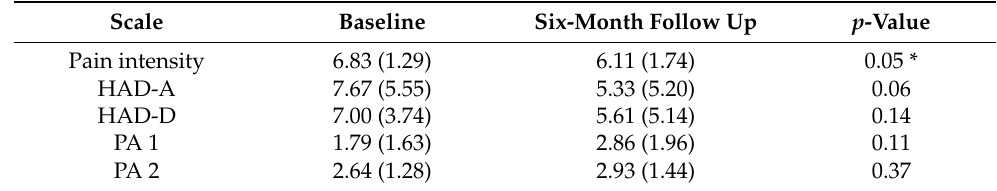
Table 2. Mean (SD) for pain intensity, hospital anxiety and depression scale (HAD-A and HAD-D, respectively), physical activity (PA 1 and PA 2) at baseline and six months after the interdisciplinary multimodal rehabilitation program. * Indicate statistically